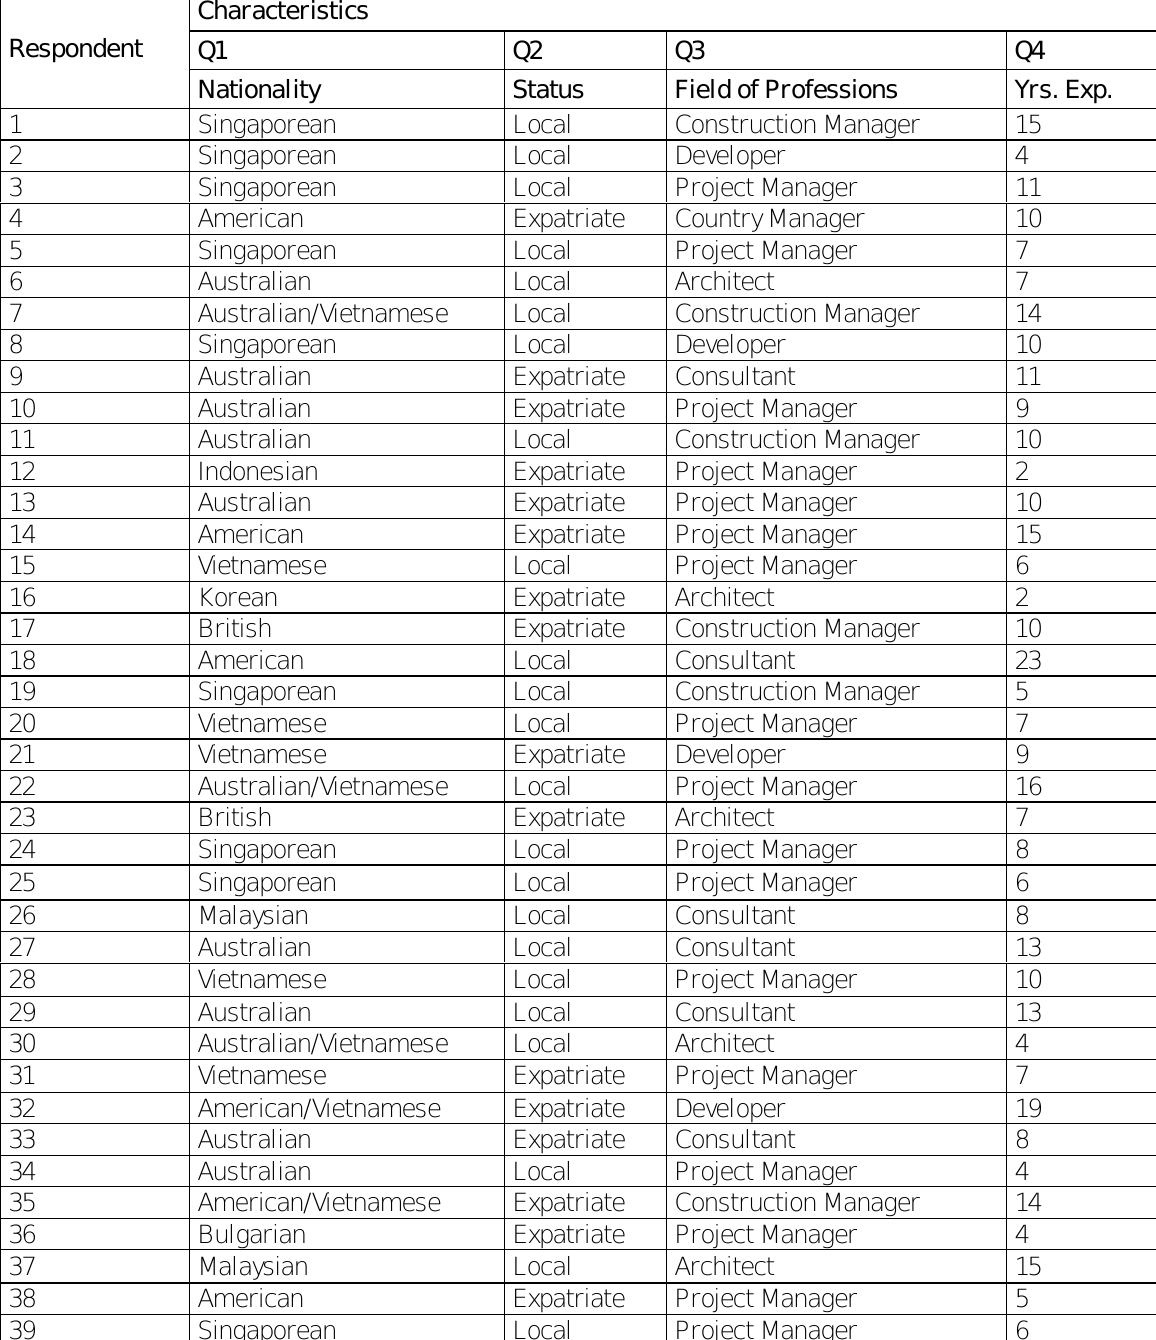
Table 1: Characteristics of the